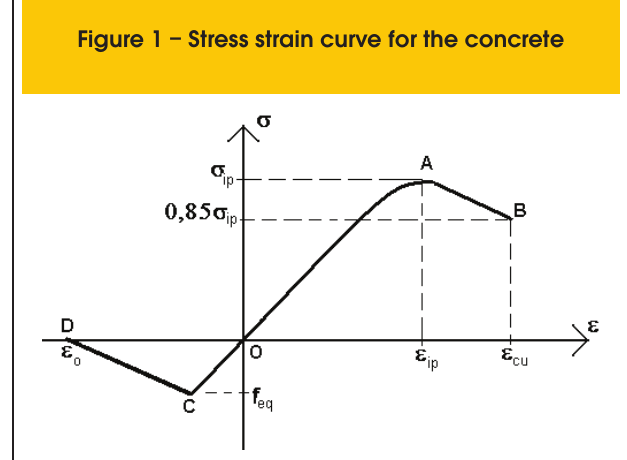
Figure 1 – Stress strain curve for the